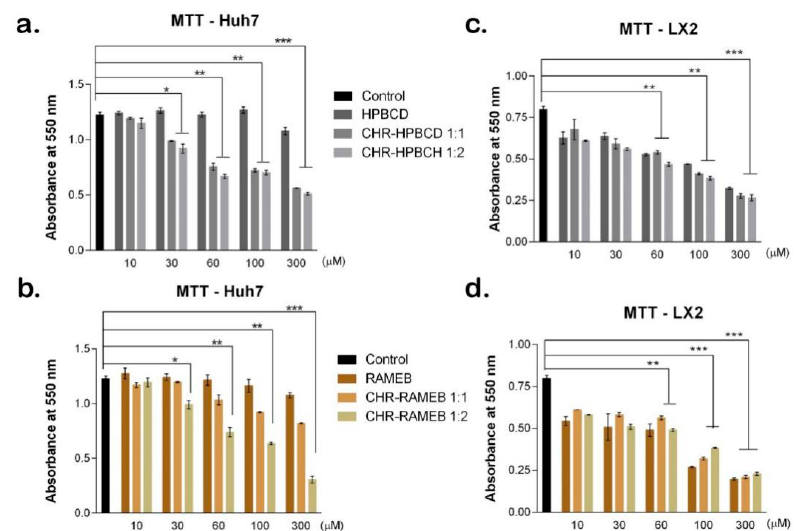
Figure 1. Huh7 and LX2 viability in contact with CD–CHR complexes evaluated by quantitative MTT test. Statistical significance: * p < 0.05; ** p < 0.01; *** p < 0.001. ( a ) Huh7 viability in contact with HPBCD complexes; ( b ) Huh7 viability in contact with RAMEB complexes; ( c ) LX2 viability in